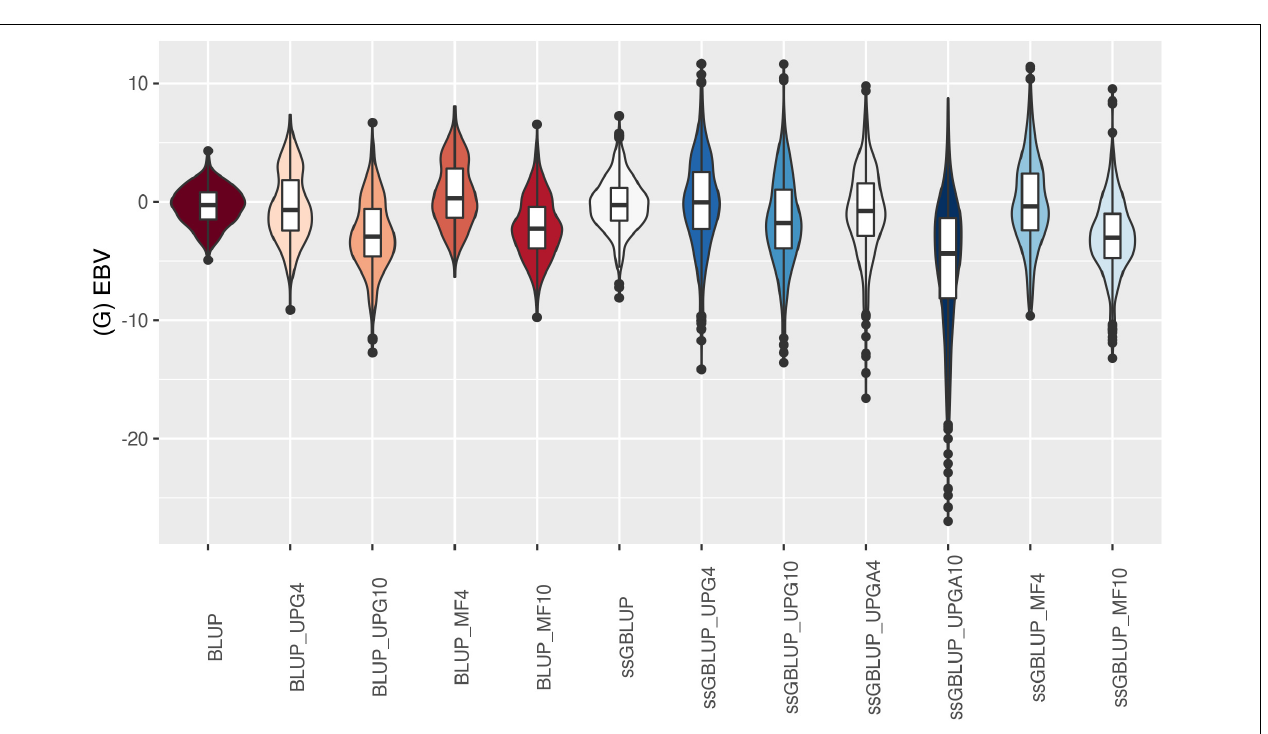
FIGURE 10 | (G)EBVs for validation animals for weaning weight maternal estimated using various models with and without genetic groups. (G)EBVs, (genomic) estimated breeding